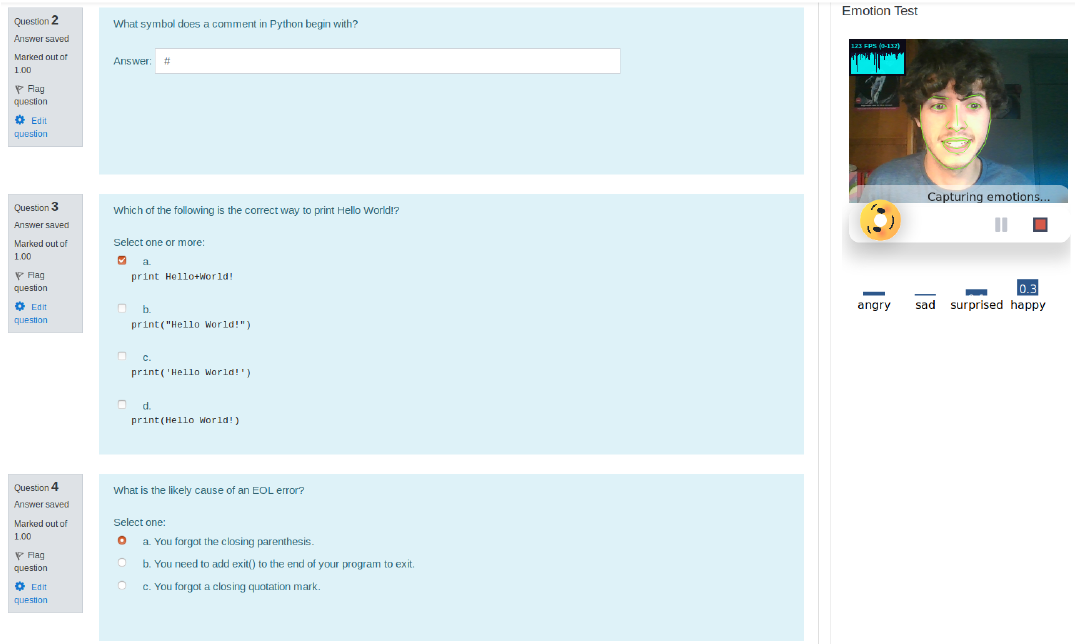
Figure 4. Emotional capture in the e-learning